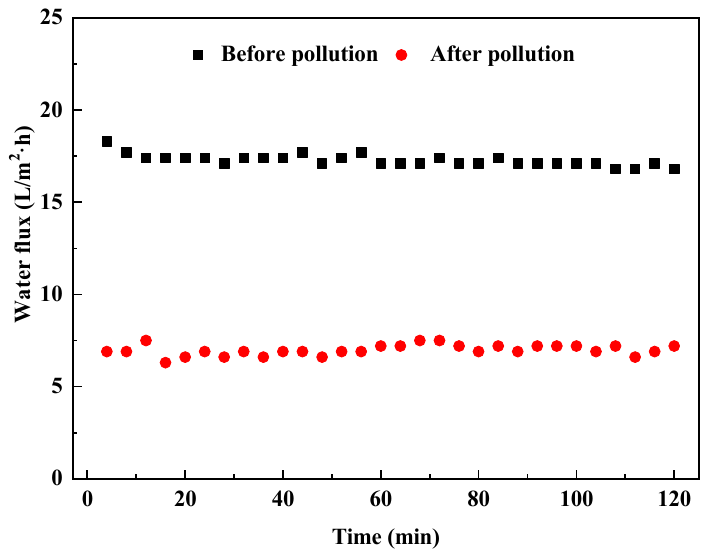
Figure 5. Changes in water flux before and after FO membrane fouling. The fouled membrane produced by the concentration of biogas slurry FO membrane can reach a pure water flux of about 11.5 L/m 2 · h after osmotic reflux (Figure 6A). Compared with the pure water flux of the fouled membrane, this cleaning method can restore about 40% of the FO membrane flux. This may be because the permeate reflux takes away some of the pollutants in the membrane fouling layer that are not adhered to the FO membrane surface [38]. Pressure reflux cleaning increases the flow of cleaning water to a certain extent and takes away more contaminants on the surface of the FO membrane. However, the improvement of pure water flux is not significant, and the recovery rate of this cleaning method for FO membrane pure water flux is also about 40%. This may be due to the formation of a tight membrane fouling layer in the same direction as the water flow during the membrane concentration process. Flushing with water in the same direction can only take away non-adhered contaminants, implying that membrane fouling was fully reversible by physical flushing [12], but most contaminants are difficult to remove in this way.